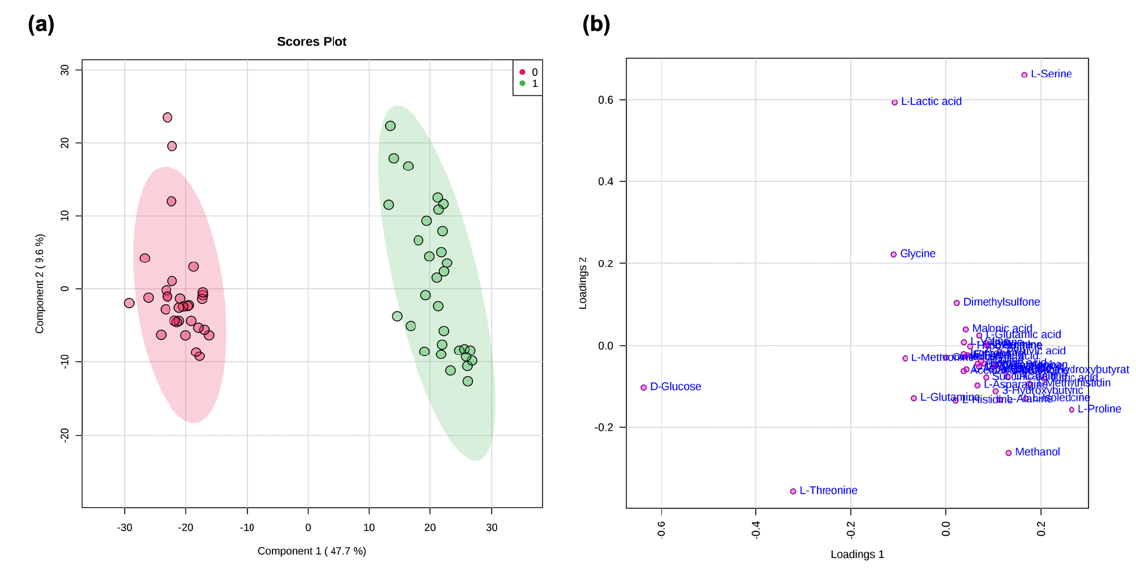
Figure 1. PCA score scatter plot ( a ) and PCA loading scatters plot ( b ) for the 1 H NMR 1D- 1 H-CPMG spectra (Bruker 600 MHz) collected in the blood sera of 31 healthy female controls (0, red) and 30 female fibromyalgia patients (1, green).